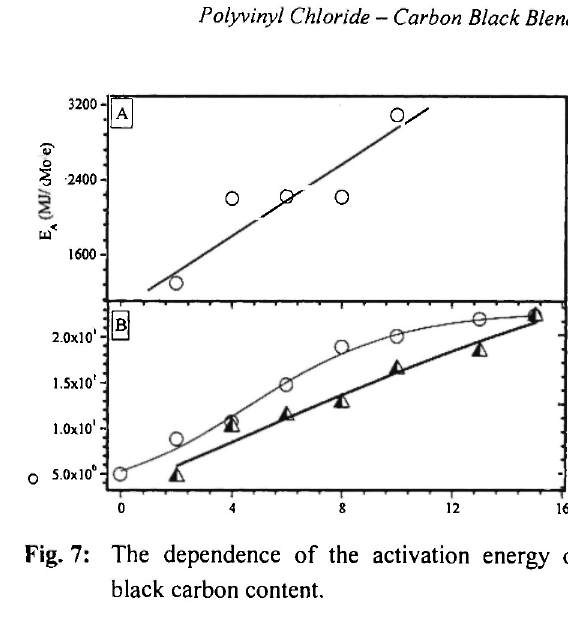
Fig. 7: The dependence of the activation energy on black carbon